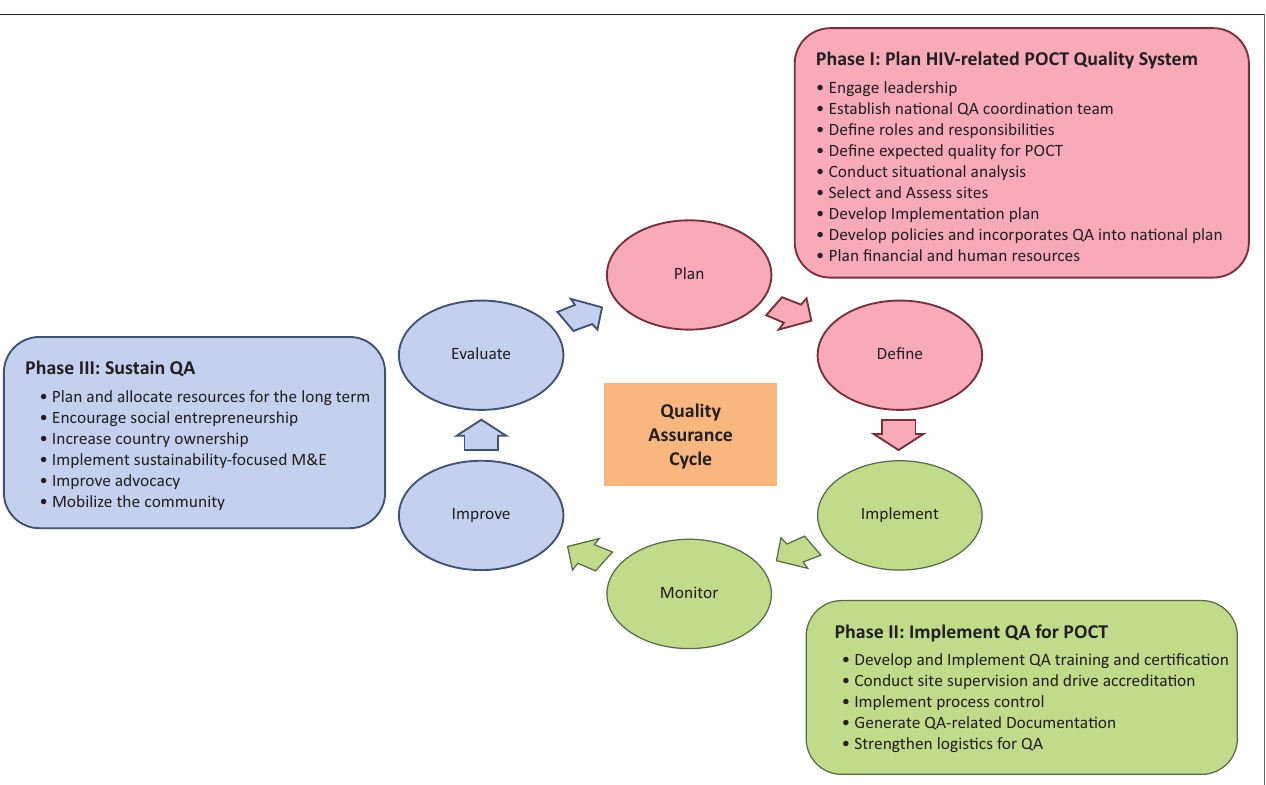
CPHL, Central Public Health Laboratory; EQA, external quality assurance; LTC, National Health Laboratories Technical Committee; LQMS, Laboratory Quality Management System; M&E, monitoring and evaluation; NHL, National Health Laboratory; POC, point-of-care; TWG, technical working